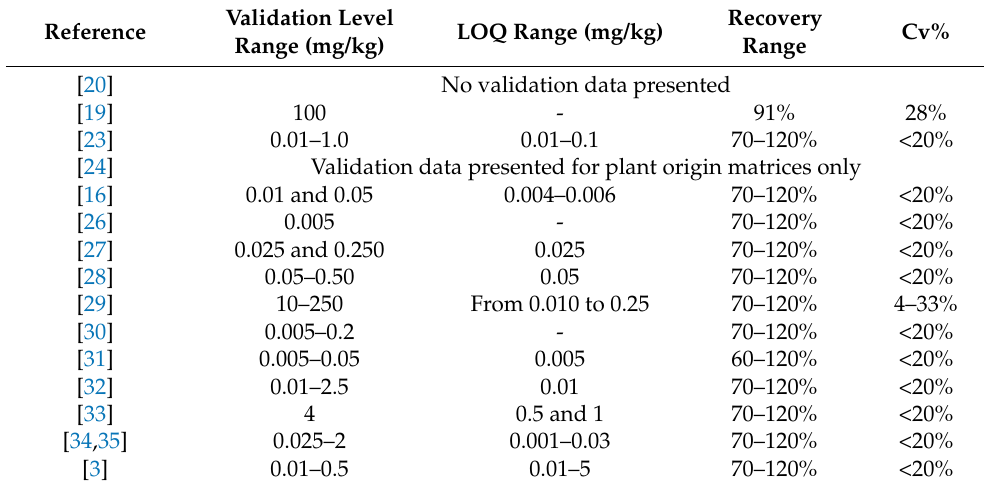
Table 2. Summary of data of performance criteria. Validation, LOQs, recovery range and